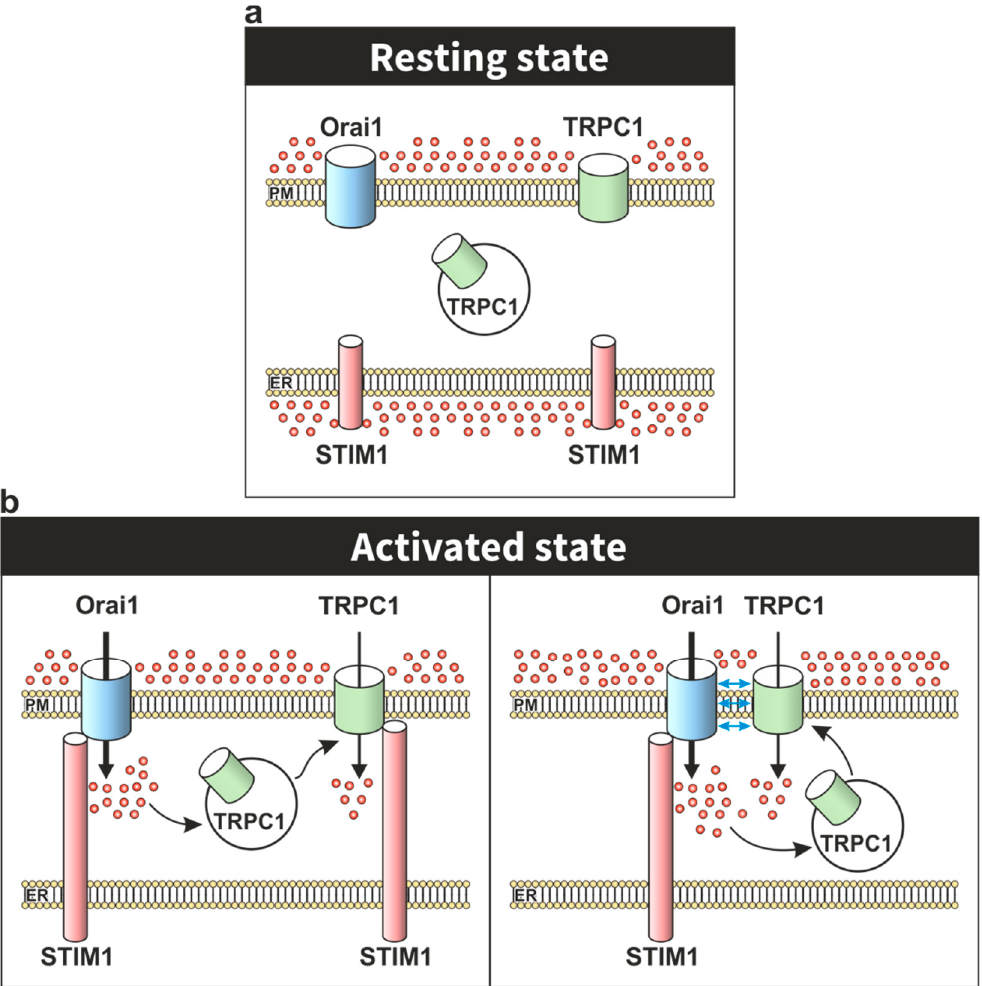
Figure 2. Cartoon depicting the activation of TRPC1 channels upon Ca 2+ store depletion. ( a ) In the resting state, TRPC1 shows both plasma membrane and cytosolic localization. ( b ) Upon Ca 2+ store depletion, Ca 2+ influx via Orai1 has been reported to induce the translocation of intracellularly-located TRPC1 to the plasma membrane where it might be activated by STIM1. The model shows two alternatives for functional (mediating Ca 2+ entry for the translocation of TRPC1 to the plasma membrane; left panel) or direct participation of Orai1 in the activation of TRPC1 (forming a STIM1–Orai1–TRPC1 ternary complex; right panel).